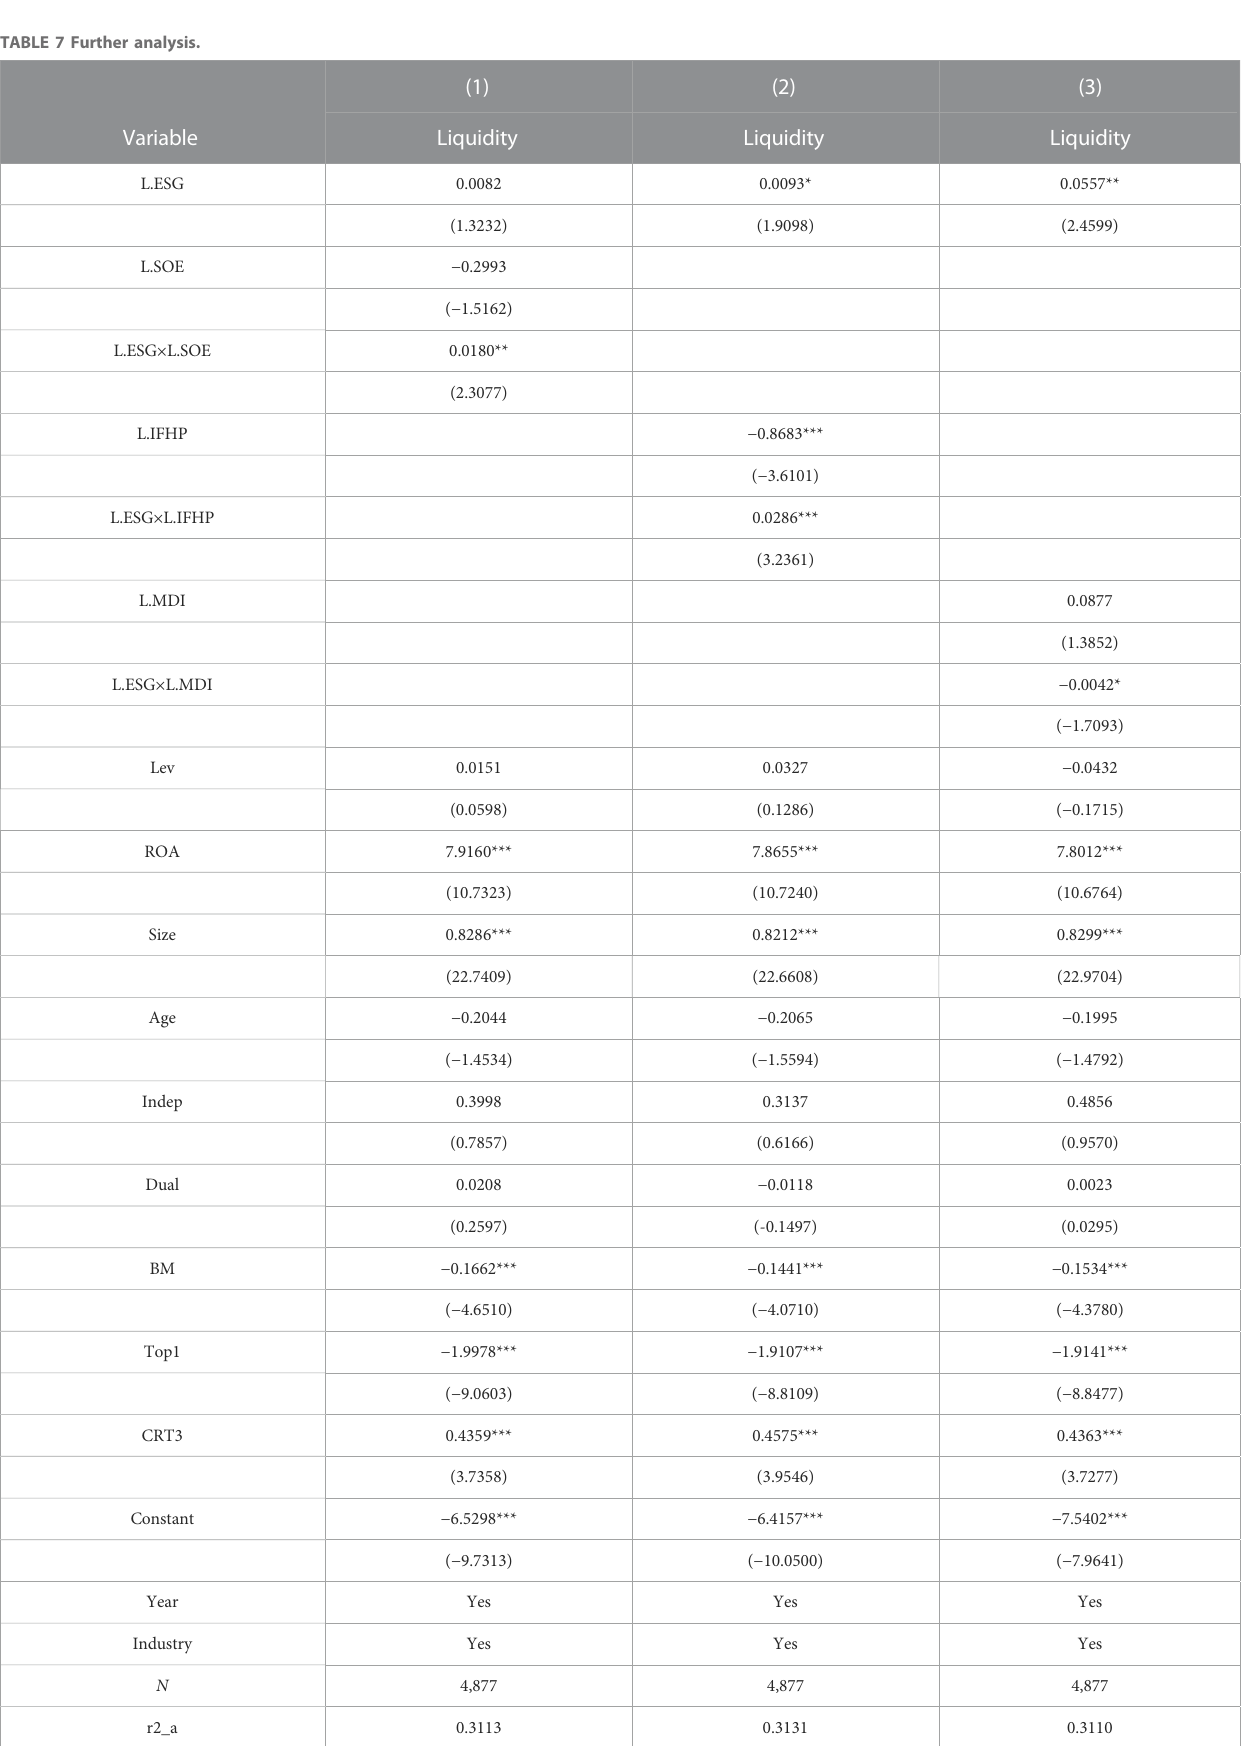
TABLE 7 Further